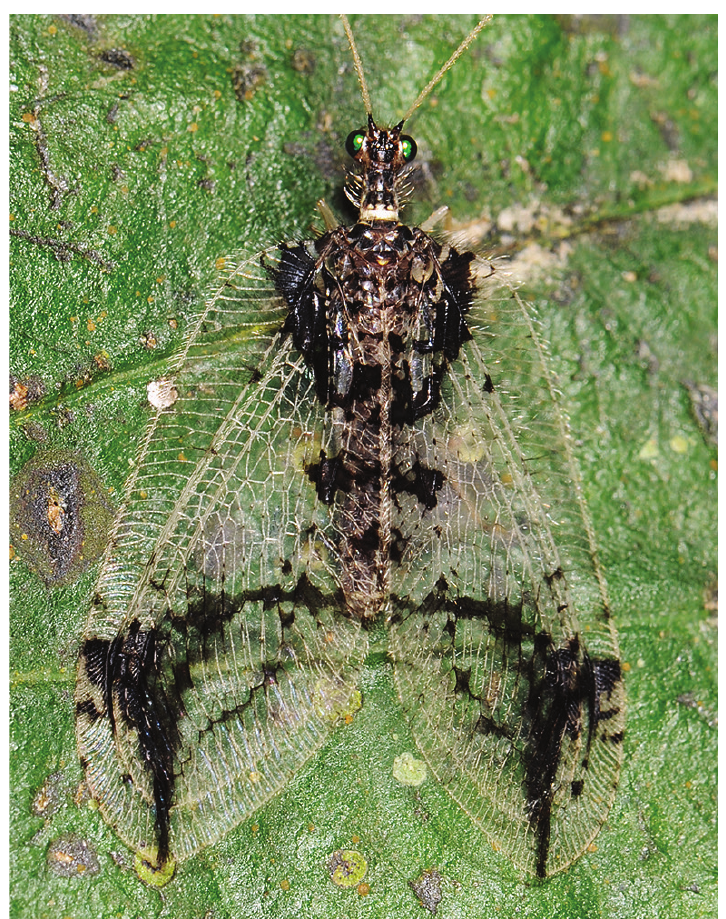
Figure 2. Gryposmylus pennyi sp. n., male, Sabah, Malaysia (photograph credit: Stephen D.